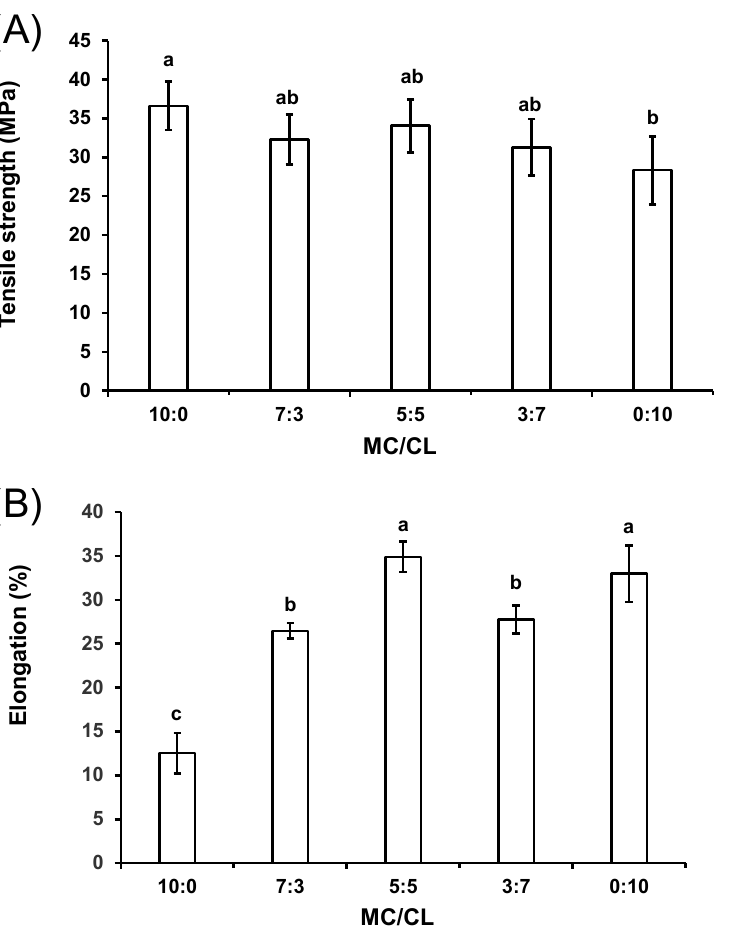
Figure 7. Mechanical properties of the MC/CL films with different blend ratios. Tensile strength ( A ); elongation ( B ). Different letters indicate significant differences ( p < 0.05).